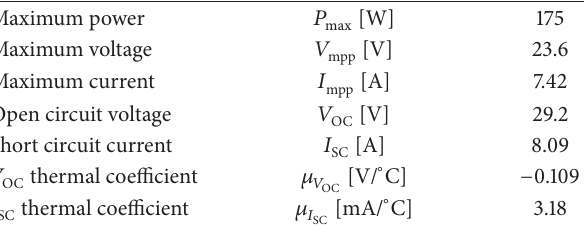
Table 1: Data sheet of Kyocera KC175GH-2.